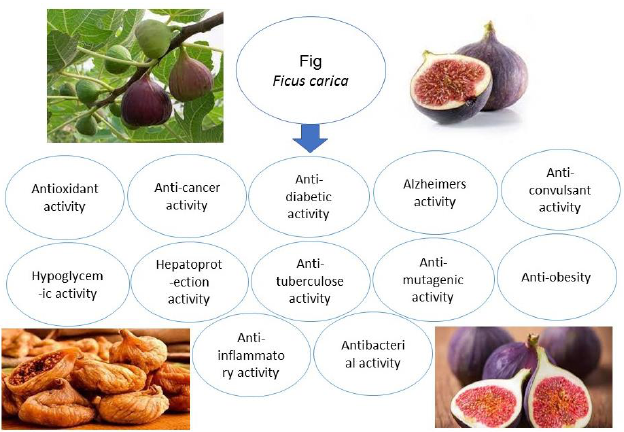
Figure 4. Health benefits of fig. Table 3. Role of different by-product of fig against chronic